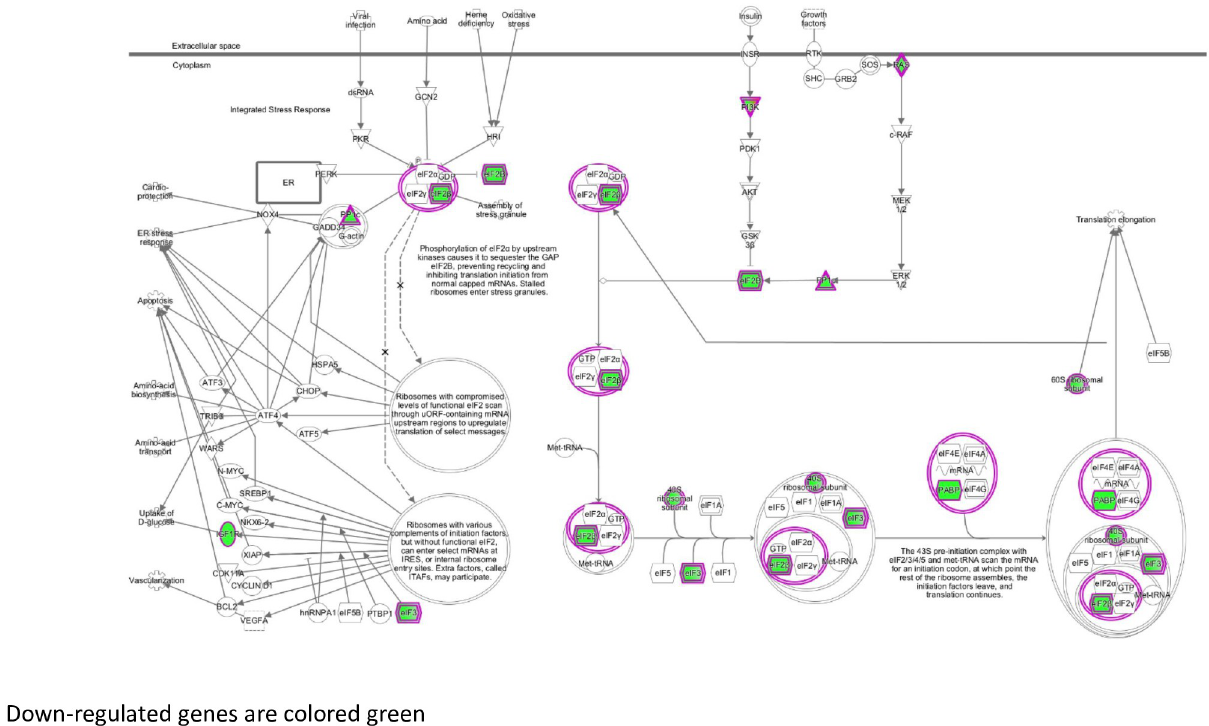
Fig 3. EIF2 signaling pathway: Male 2-year baseline module. Green fill indicates genes positively correlated with lesion burden.